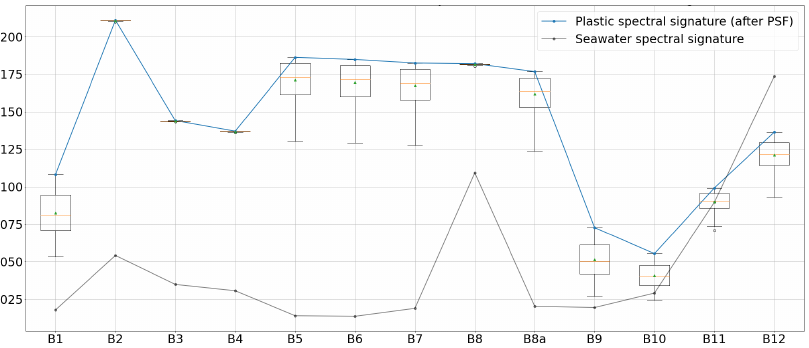
Figure 7. Results of all the possible jitters for each band by selecting the maximum reflectance values. Plastic patch of size 30m × 30m. The triangle represents the average of the corresponding dataset and the orange line, the median.